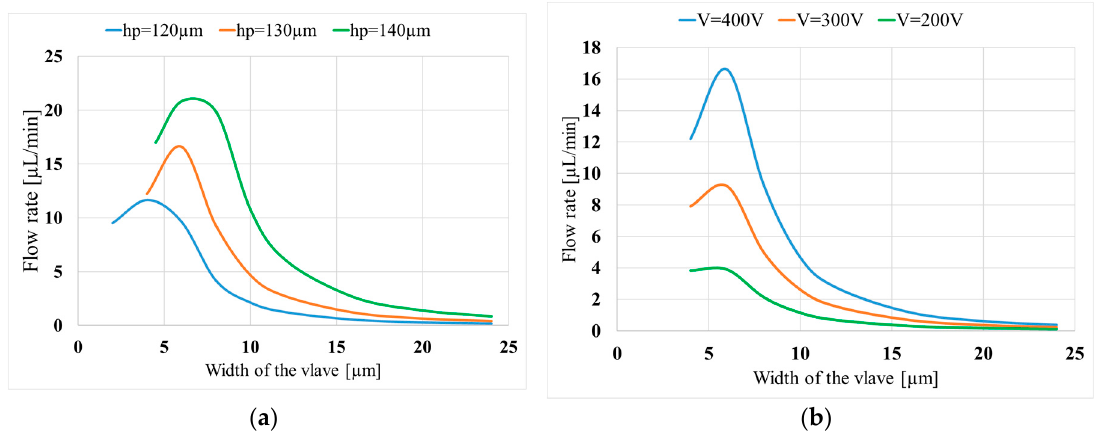
Figure 9. Variation of the obtained flow rate with the valve width (w): ( a ) for three valve lengths ( h p ) ( L p = 5mm, V = 400 V); ( b ) for three applied voltages (V) ( L p = 5mm, h p = 130 μ m).